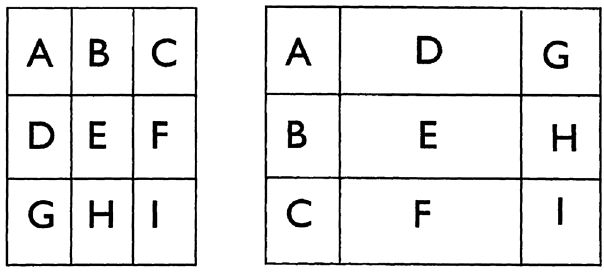
FIG. 2. Standard figure in the context of another